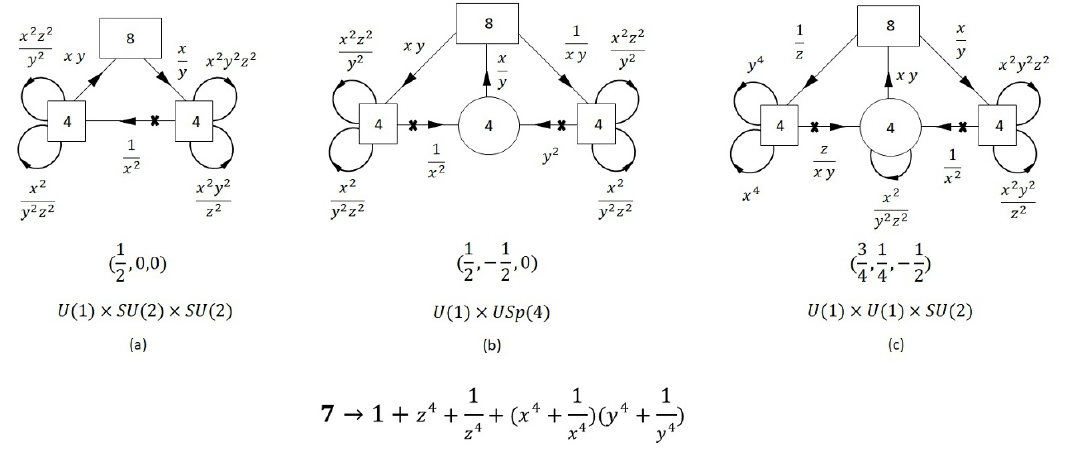
Figure 4 . 4 d tubes for the SO(7) (cid:2) E 7 conformal matter. Below each tube is the (cid:13)ux associated with it and the global symmetry it preserves (using the notation of [7]). Finally we show how the SO(7) is built in term of the symmetries we de(cid:12)ned in 4 d